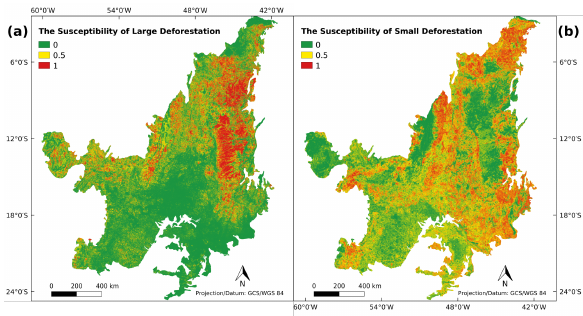
Figure 2. (a) The susceptibility of large deforestation ( i.e. > = 0.5 km 2 ). (b) The susceptibility of small deforestation ( i.e. < 0.5 km 2